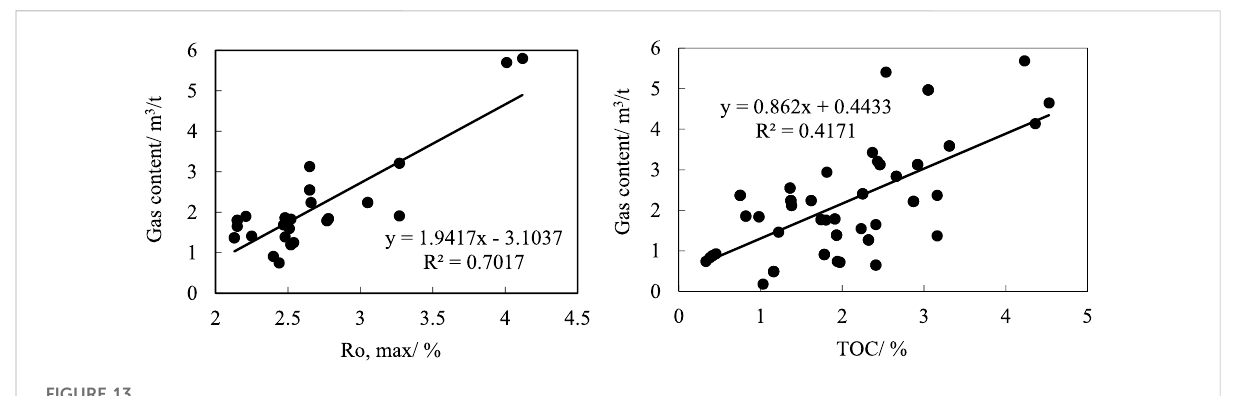
FIGURE 13 Relationships between gas content versus R o,max (left) and TOC (right).